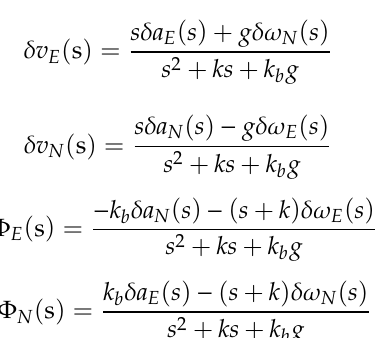
Figure 3. Block diagram of the self-alignment loop. Control angular rates ( (cid:2033) (cid:3015)(cid:3030) , (cid:2033) (cid:3006)(cid:3030) ) are calculated by horizontal velocities ( v E , v N ) to make these velocities zero. A horizontal attitude (roll or pitch) is calculated by either control rate. Vertical attitude (heading) is calculated by both control rates.